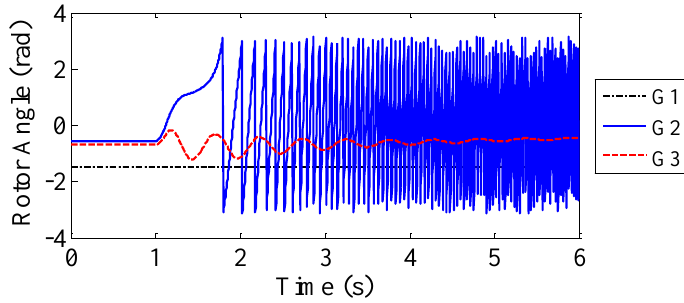
Figure 11. Rotor angles of synchronous generators with the 131 ms fault on line 7–8.